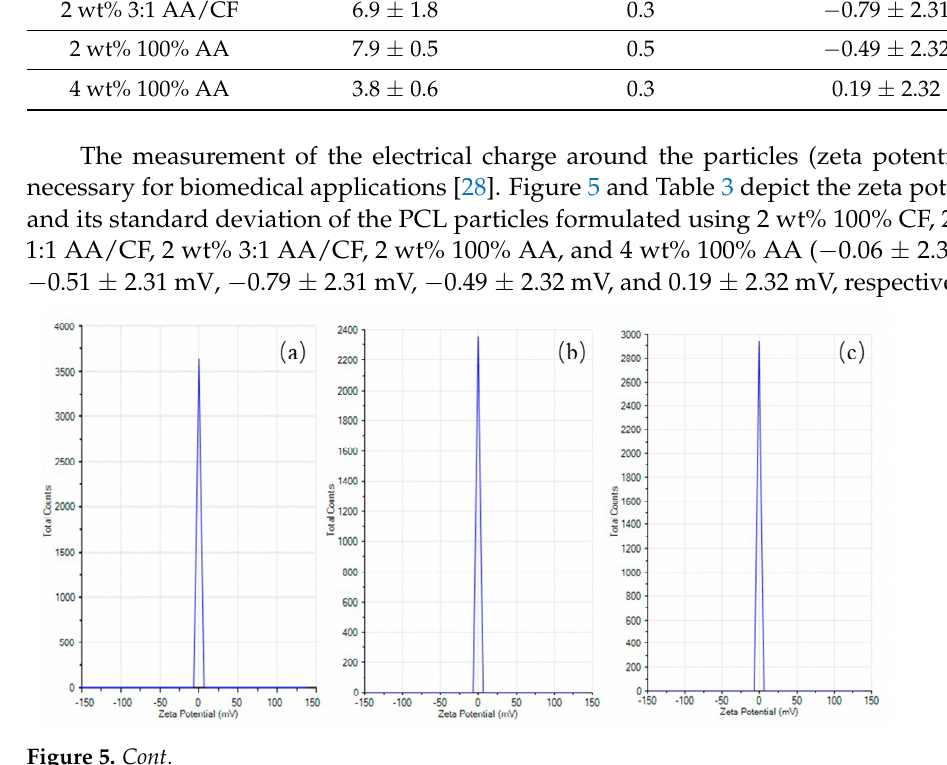
Figure 5. Zeta potential measurement for synthesized PCL particles: ( a ) 2 wt% 100% CF, ( b ) 2 wt% 1:1 AA/CF, ( c ) 2 wt% 3:1 AA/CF, ( d ) 2 wt% 100% AA, and ( e ) 4 wt% 100% AA. 4. Discussion High-molecular-weight PCL (Mw = 80,000 g mol − 1 ) was used at 2 wt%, 4 wt%, and 6 wt% concentrations to produce electrosprayed specimens. Usually, high molecular weights are responsible for producing a spherical morphology via the precipitation of the entangled chains after solvent evaporation [4]. In the current study, the production of microparticles absent of fibers was achieved using the following solutions: 2 wt% PCL with 100% CF; 2, 4, and 6 wt% PCL with 100% AA; and 4 wt% PCL with 100% AA. Zang et al. [4] used PCL with molecular weights ranging from 70,000 to 90,000 g mol − 1 dissolved in CF in their experiments. They reported the inability to produce particles even at very low PCL concentrations (0.5 wt%), in which only fibers were observed. Wang and collaborators [18] prepared a solution for the electrospray technique using a 10% PCL concentration and AA as the only solvent. In this study, round and smooth microspheres with the presence of fine fibers were observed. The authors related the presence of fibers to the high polymer concentration and consequently to the high entanglement of the polymer chains. A high polymer concentration is also associated with an increase in polymer solution viscosity. Taking this into consideration, solutions with low viscosity are easily broken into droplets by the applied voltage, resulting in particles, while high- viscosity solutions are more likely to produce fibers [29]. Similar outcomes were found in the present study. In this study, round particle morphology was only acquired in particles produced using 100% CF as the solvent. However, the use of such a solvent produced a significant increase in particle size compared with the remaining groups, a fact that was also directly proportional to the increase in PCL concentration. The results obtained in our study agree with the ones observed by Malagón-Romero et al. [30]. After testing a few parameters